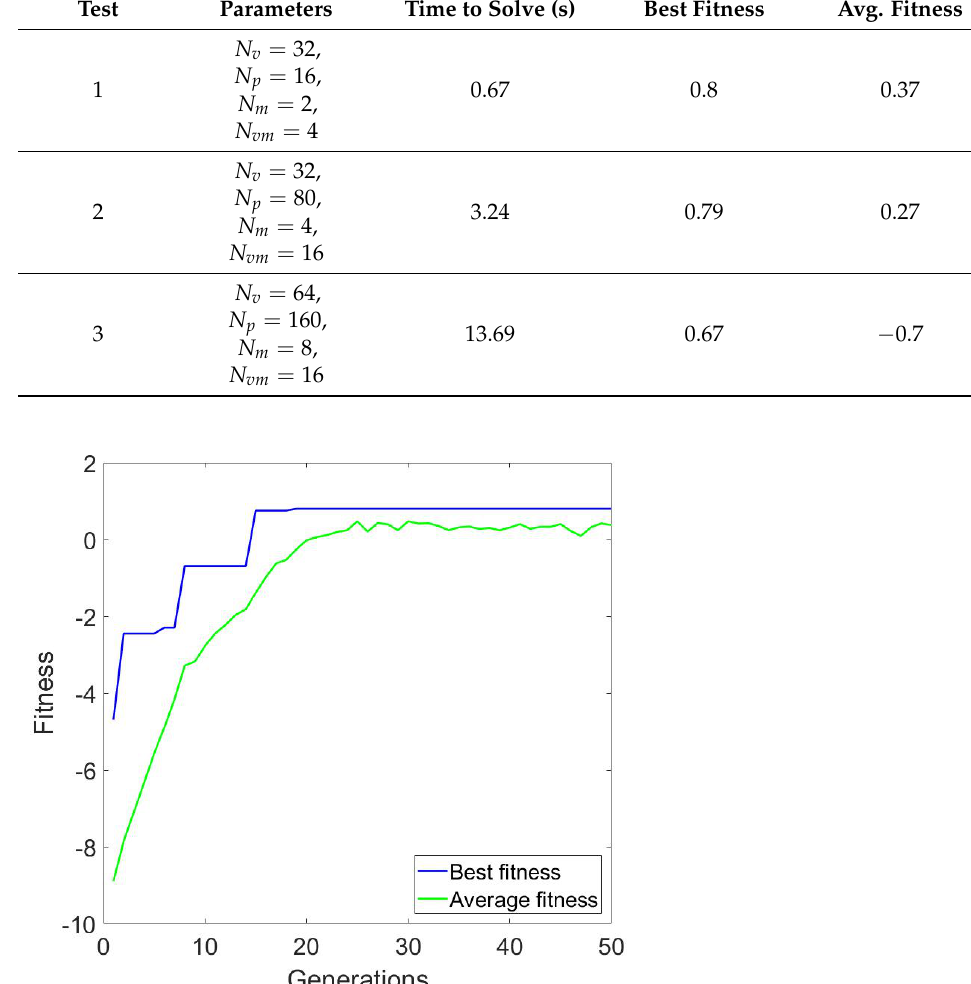
Figure 4. Average and best fitness for experiment with input N v = 32, N p = 16, N m = 2, N vm = 4. No penalization used for suboptimal NUMA